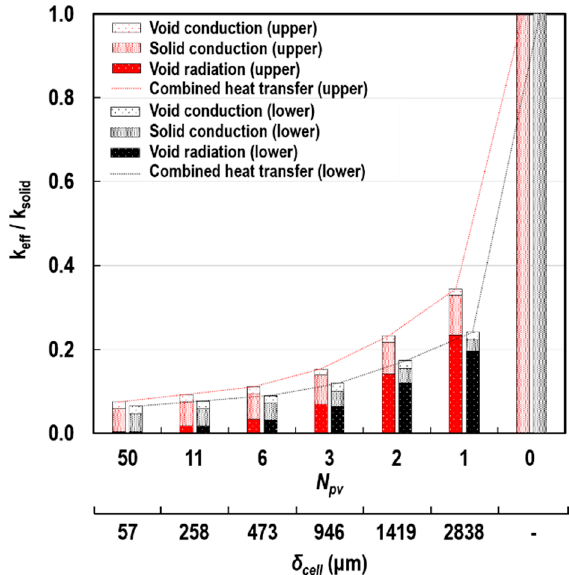
Figure 17. Variations in the k eff / k solid ratio and the individual contributions of the heat transfer modes according to δ cell at L = 3 mm, Φ = 0.895, and 𝑞(cid:4662) (cid:2919)(cid:2928)(cid:2928)(cid:4593)(cid:4593) = 50 kW/m 2 .